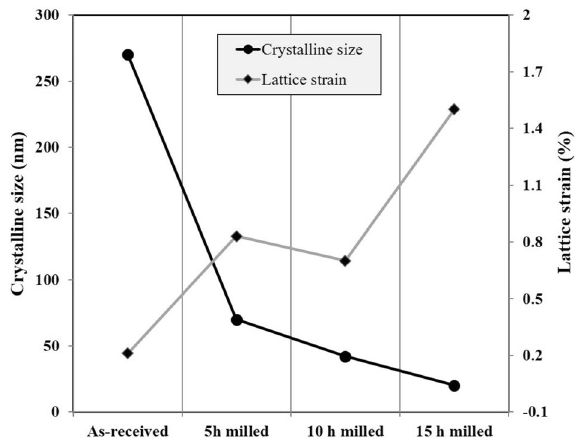
Figure 6. Variations of values of crystallite size and lattice strain percentage of Ni-rich γ-phase in the commercial and nanocrystalline MCrAlY powders as a function of milling duration.